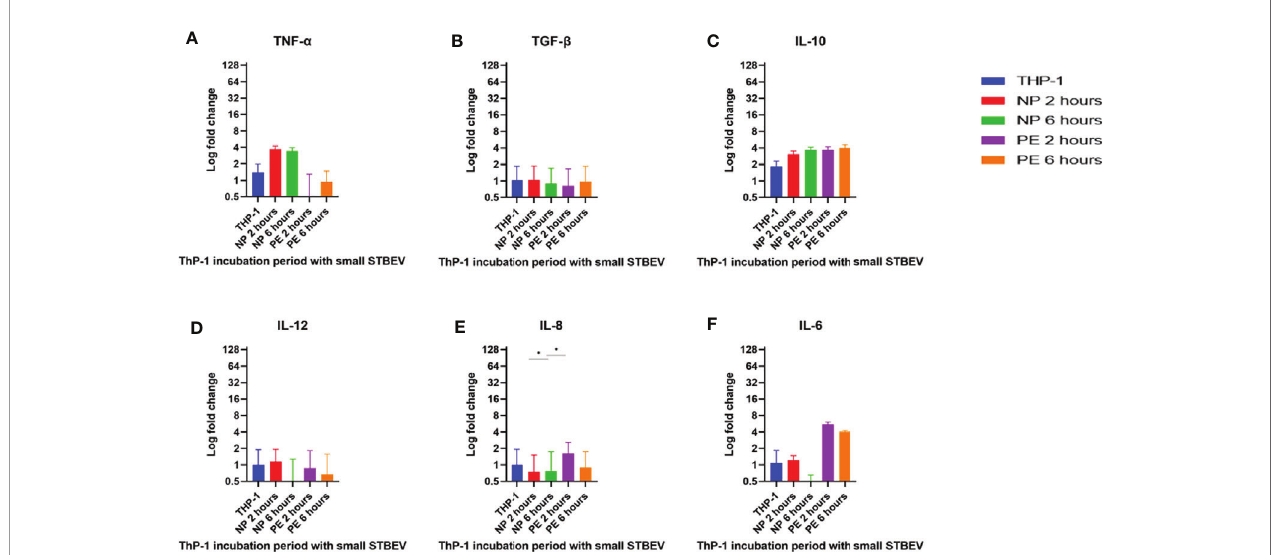
FIGURE 8 | RT-qPCR analysis of the small STBEV induced expression of cytokines by differentiated THP-1 cells. Cells were incubated with small STBEVs from NP and PE placentae at 2 and 6 hour time-points. In control experiments, cells were incubated with fi ltered PBS at the same time-points. mRNA expression was measured using real-time RT-qPCR for small STBEVs; TNF- a (A) , TGF- b (B) , IL-10 (C) , IL-12 (D) , IL-8 (E) and IL-6 (F) . Data were normalised to 18S rRNA expression that was used as an internal reference gene. Values calculated as mean ± SEM of value from cells treated with 1 X 109 of STBEV. To determine signi fi cant difference in expression, one-way ANOVA was performed on data: *p ≤